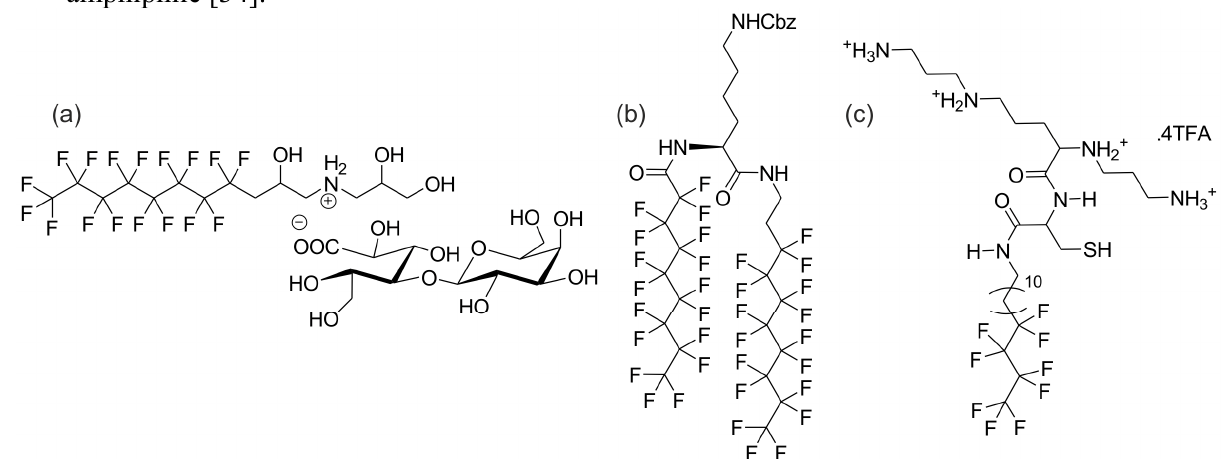
Figure 2. Examples of fluorocarbon amphiphiles; ( a ) sugar-based fluorocarbon amphiphile [30]; ( b ) fluorinated amphiphilic building block used for the synthesis of glycopeptide conjugates [32]; and ( c ) perfluorinated dimerizable polycationic amphiphile